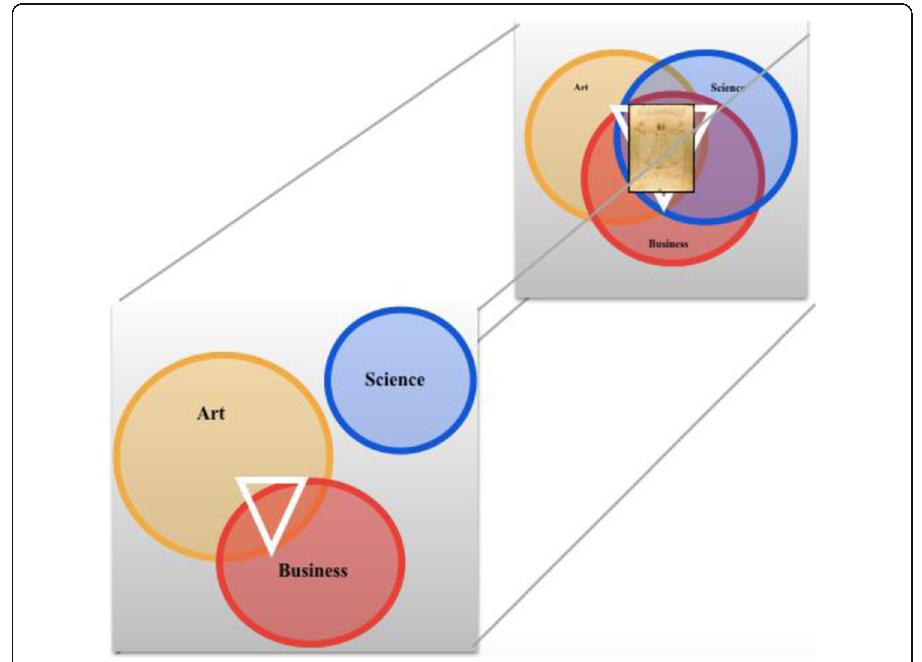
Fig. 4 Model of the Intersection of Art, Science and Business as Roadmap to create Sustainable Value. ©